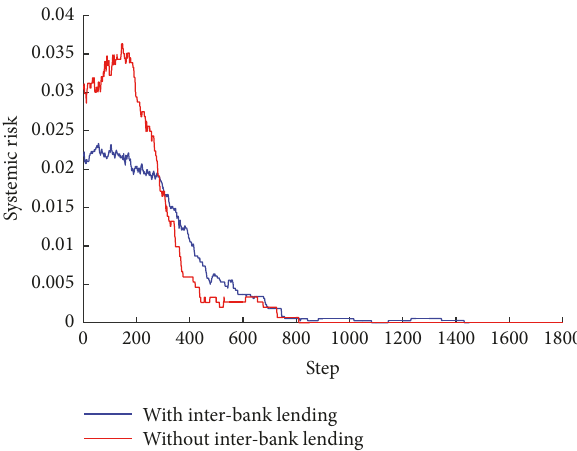
Figure 11: The evolution process of the system with interbank lending and without interbank lending. The parameters are set as 𝑑 = 0.0533 , 𝛿 = 0.009 , 𝜃 = 0.04 , 𝑝 = 0.05 , 𝜎 𝑎 V 𝑒 = 0.25 , 𝐴 = 1000 , 𝑤 = 500 , 𝜒 = 0.3 , 𝛽 = 0.25 , 𝐵𝑎𝑛𝑘𝑁𝑜 = 200 , 𝜎 𝑤 𝐴𝑠𝑠𝑒𝑡𝑁𝑜 = 150 , 𝑟 = 0.004 , and 𝑟 = 0.008 . 𝑎 𝑎